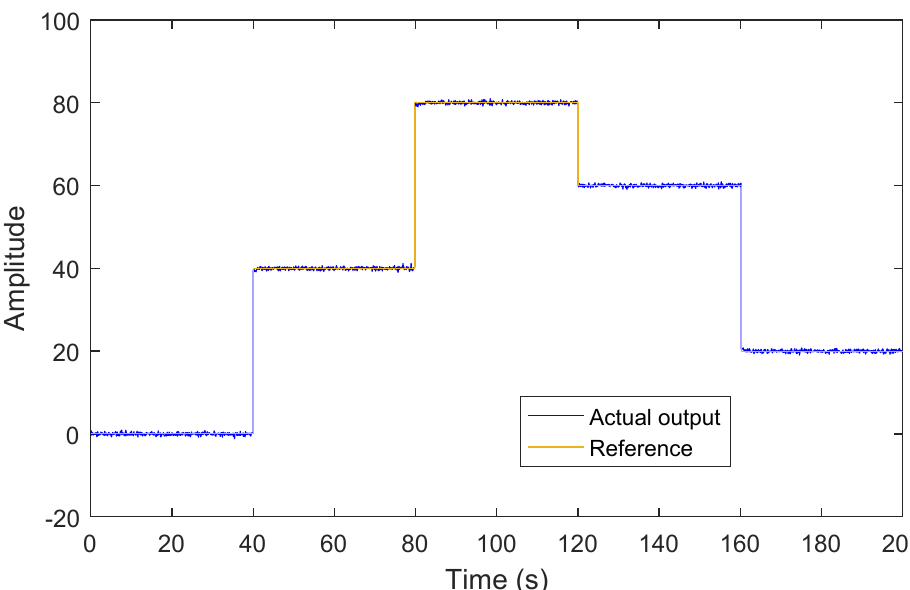
Figure 10. Response of SLSSO-based controller for variable step input with disturbance for loop